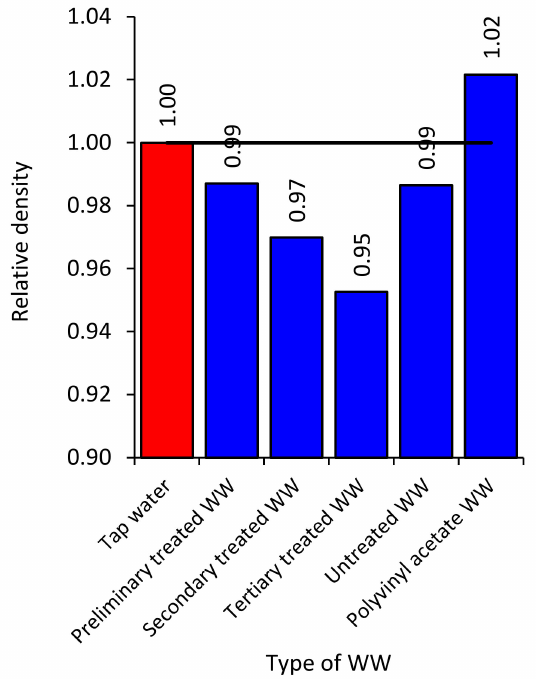
Figure 14. Effect of primary-, secondary- and tertiary-treated WW on the density of concrete